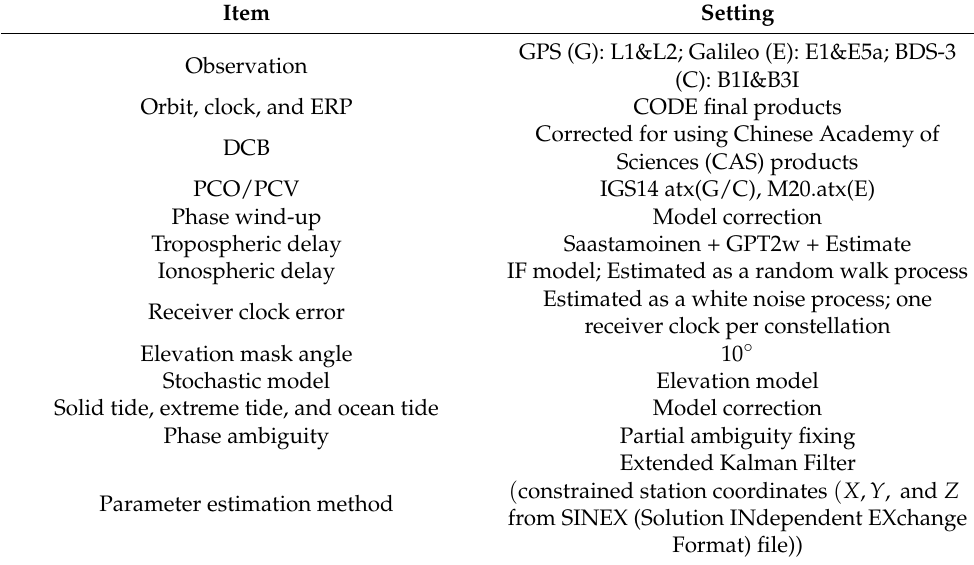
Table 1. The PPP solution strategy and frequency parameters for each system.